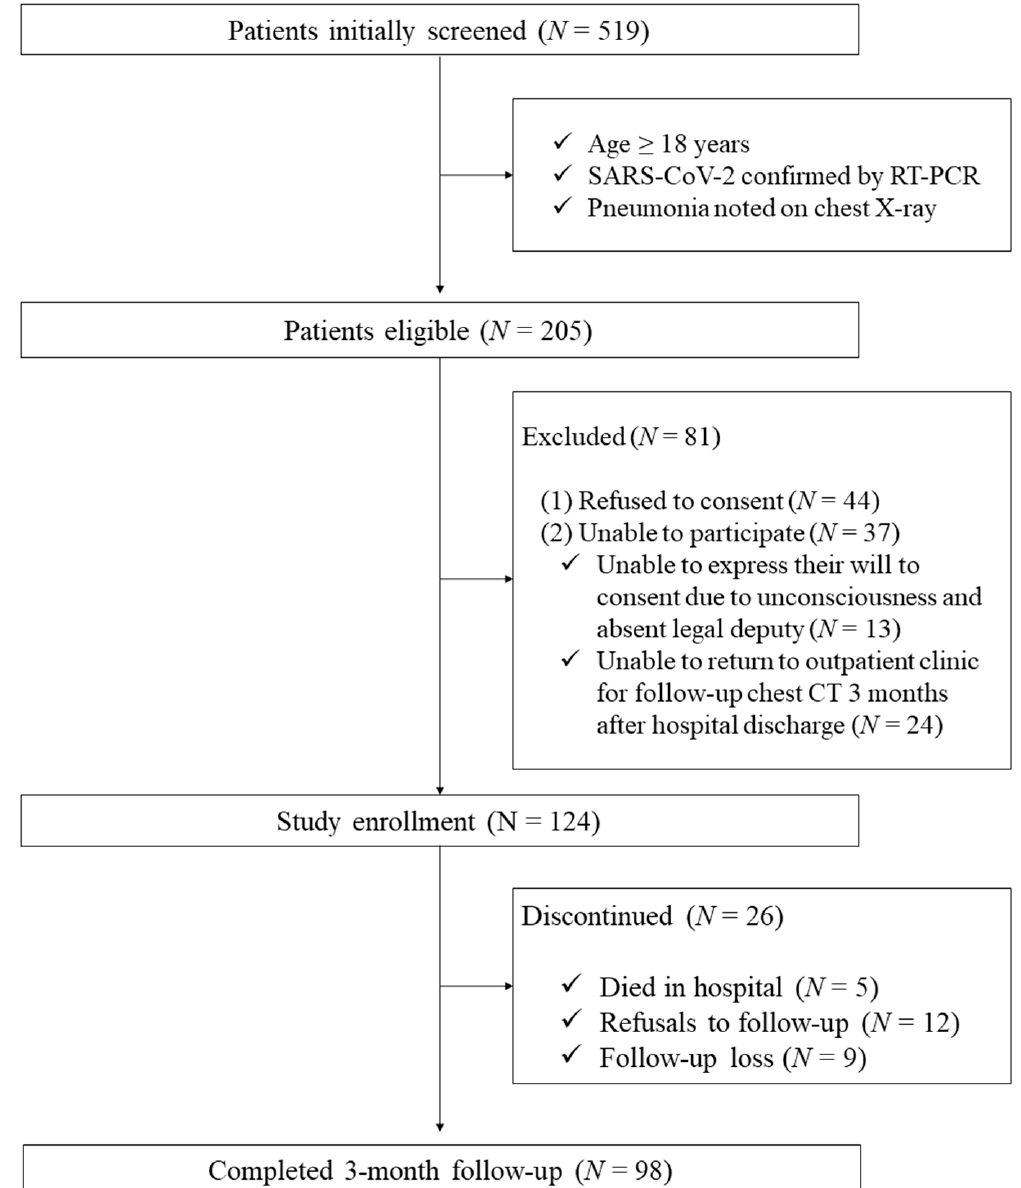
Figure 1. Enrollment flowchart. SARS-CoV-2: severe acute respiratory syndrome coronavirus 2; RT-PCR: reverse transcriptase-polymerase chain reaction; CT: computed tomography.